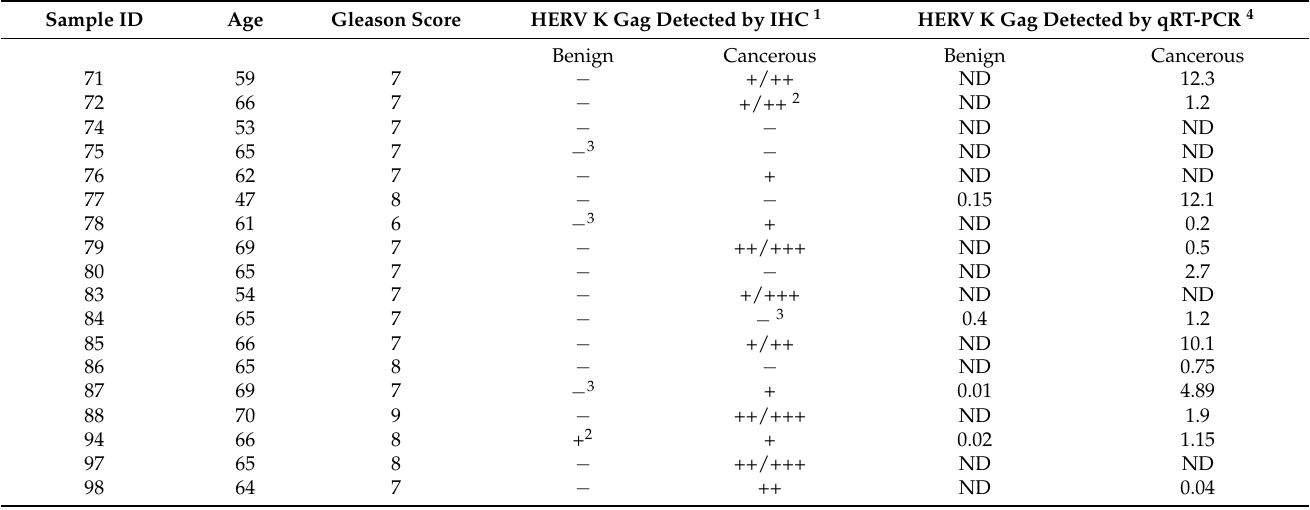
Figure 3. Associations between expression of various HERV transcripts in prostate cancer tissue. ( A ) Heat map showing the differential expression (log 2 fold difference; FD) of HERV RNA transcripts in prostate cancer tissues from men with prostate cancer. Left panels show expression of HERV-K Np9, HERV-W Gag, HERV-E Pol and HERV-H Pol in malignant regions relative to benign regions of the prostate (each standardised to GAPDH). Right panels show expression of HERV-K Gag and HERV-E Env in both benign (B) and malignant (M) regions relative to expression of GAPDH (due to transcripts being undetectable in many benign tissue samples). ( B ) Correlation matrix showing the association between expression levels of the various HERV transcripts as determined by non-parametric Spearman’s correlation. For HERV-K Gag and HERV-E Env, the expression level in malignant tissues (relative to GAPDH) was analysed, whilst for all other transcripts, the expression in malignant tissue relative to benign tissue (both standardised to GAPDH) was used. Values show Spearman’s rho. * and ** indicate p < 0.05 and 0.01, respectively. Table 2. Detection of HERV-K Gag protein in malignant and benign prostate tissue from men with prostate